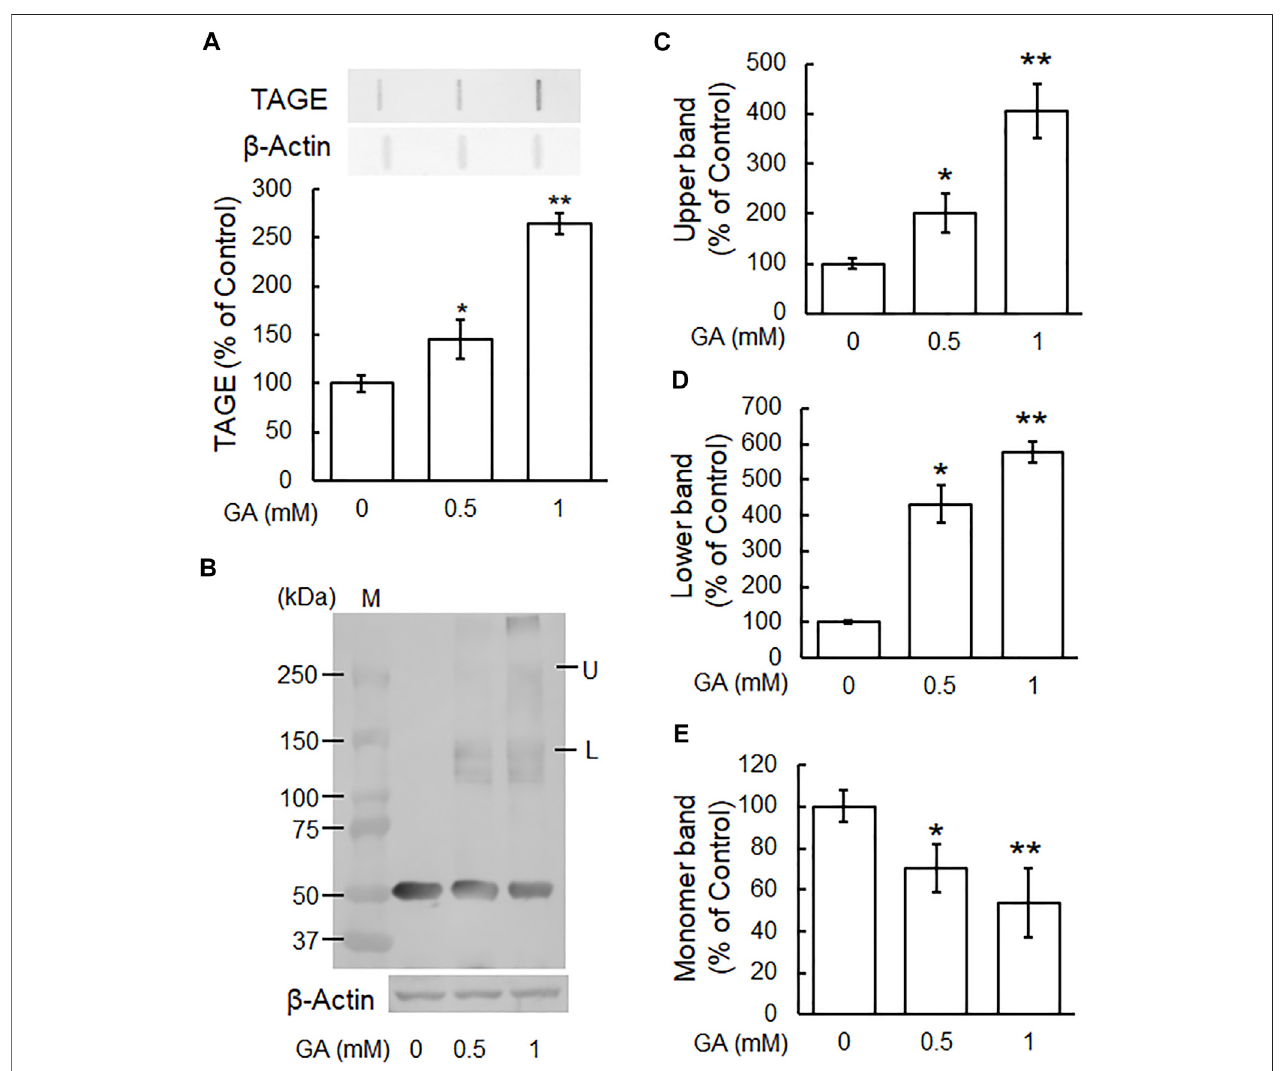
FIGURE 2 | β -Tubulin dose-dependently increased abnormal aggregation by GA in SH-SY5Y cells. (A) Cells were treated with 0, 0.5 or 1 mM GA for 12 h. TAGE weremeasuredbyslotblotanalyseswithananti-TAGEantibody.GraphicalrepresentationofTAGEbandsinaslotblot.* p < 0.05,** p < 0.01vs.0 mM( n =3). (B – E) The levels of β -tubulin aggregation were detected using anti- β -tubulin antibody. (B) Western blot data obtained using anti- β -tubulin antibody. M: Marker, L: lower band, U: upperband. (C) ThelevelsoftheupperbandsoftheGA-treated β -tubulinband. (D) ThelevelsofthelowerbandsoftheGA-treated β -tubulinband. (E) Thelevelsof the monomer bands of GA-treated β -tubulin. * p < 0.05, ** p < 0.01 vs. 0 mM ( n = 3).